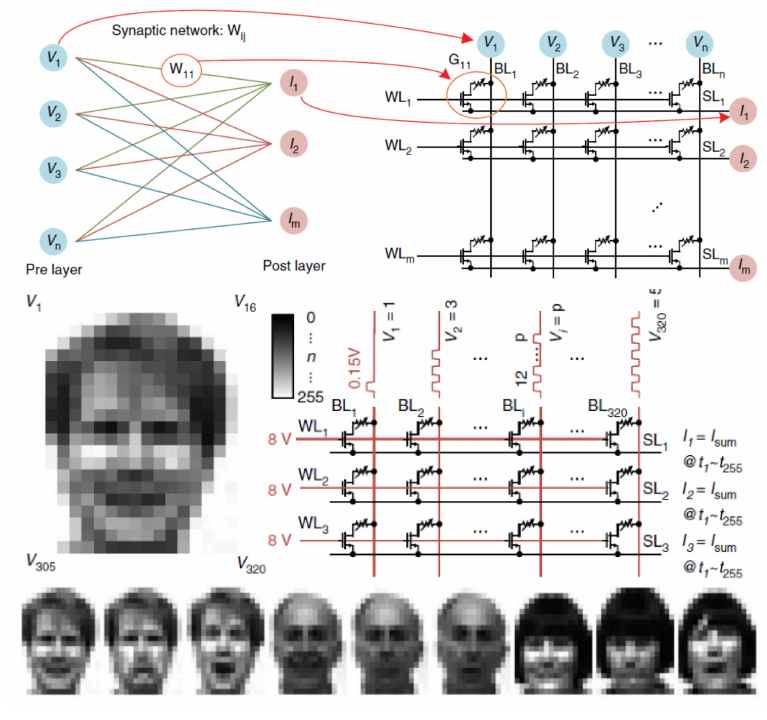
Figure 13. Face recognition task is realized in 1T1R array.